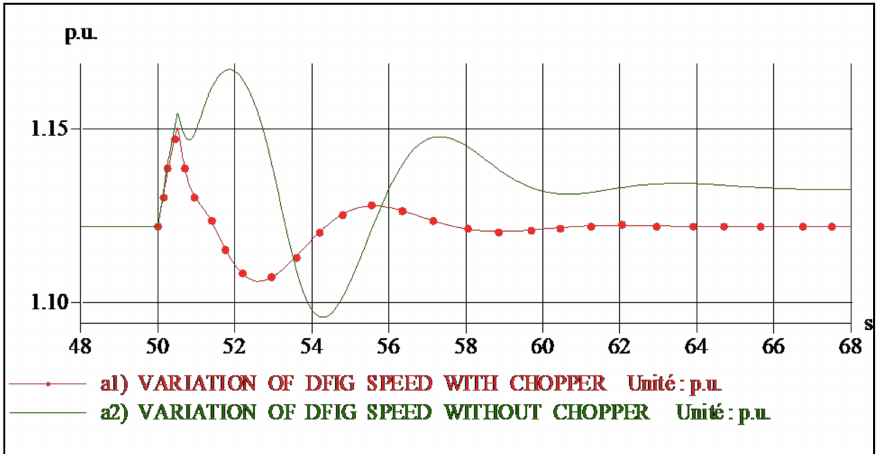
Figure 10. Variation of DFIG speed with and without a chopper.